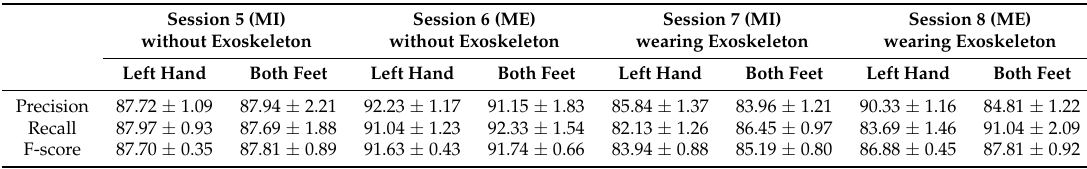
Table 4. The mean precision, recall and F-score of the two classes of four sessions in the online-control phase across all subjects (in